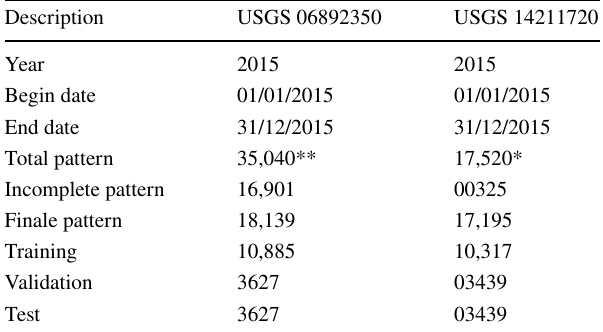
Table 4 Summary description of dataset